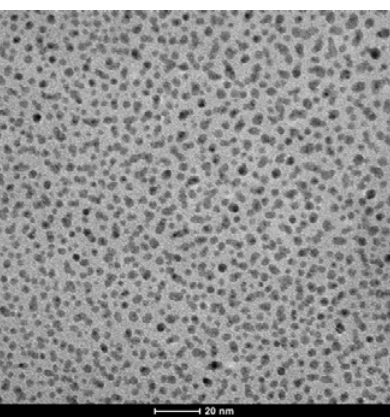
Figure 3. TEM micrographs of